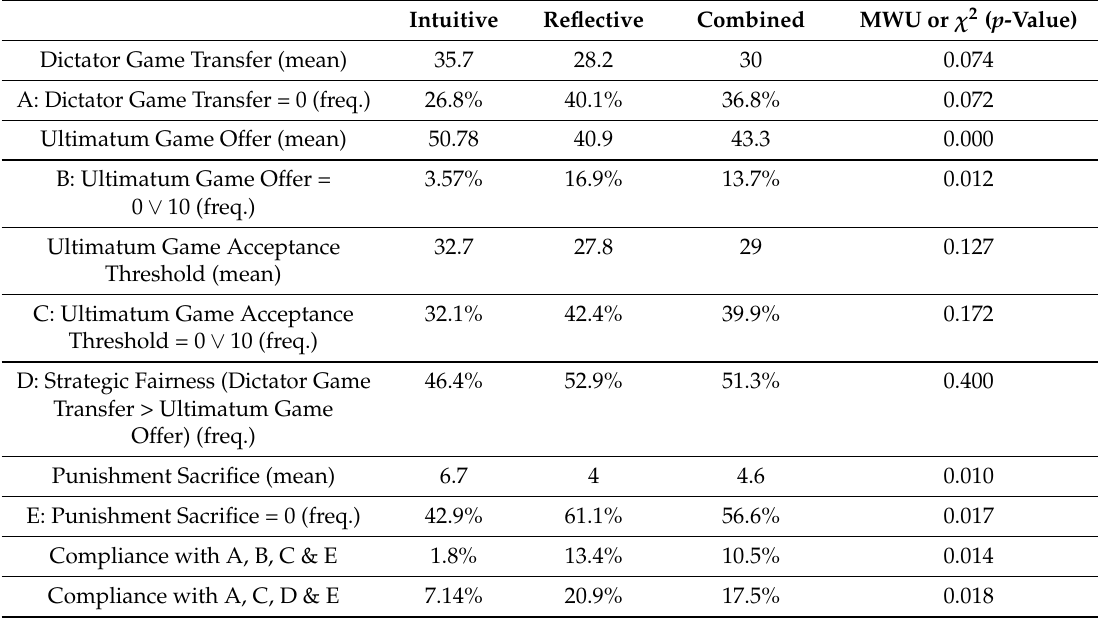
Table A5. Results Excluding the Residual Group by Intuitive (Reflective)